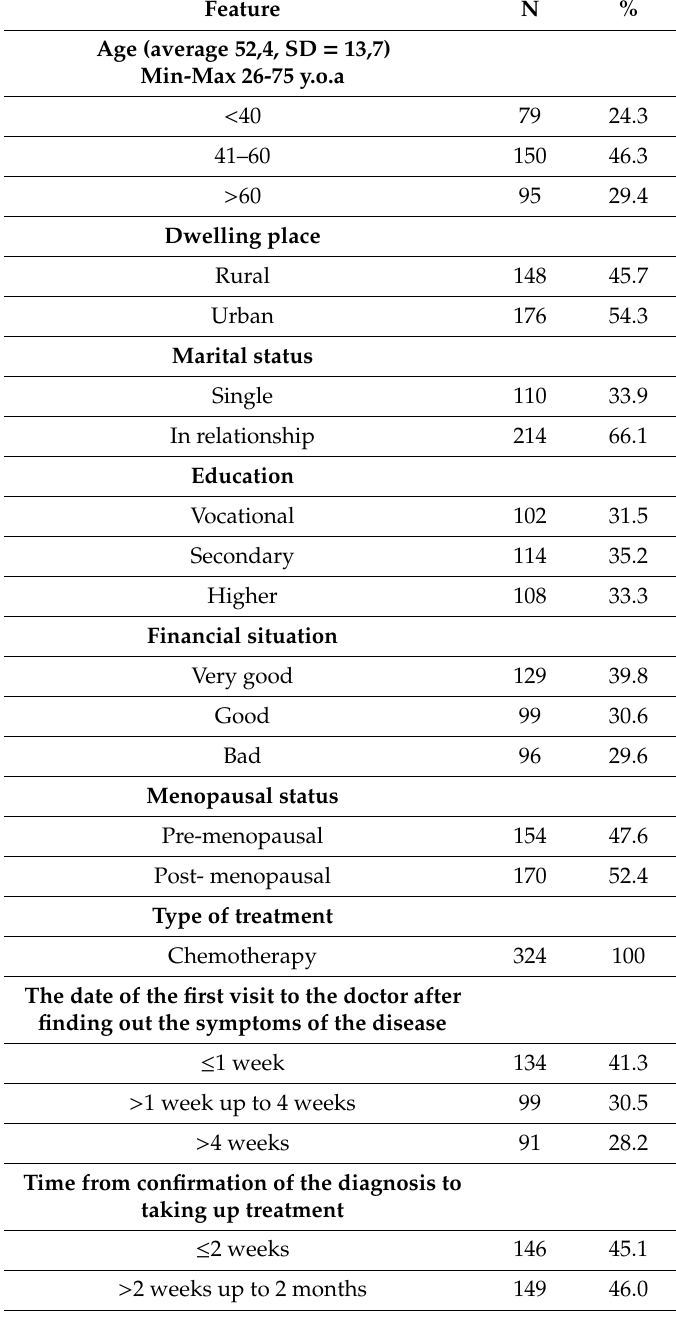
Table 1. Patient characteristics in terms of sociodemographic and medical (clinical)